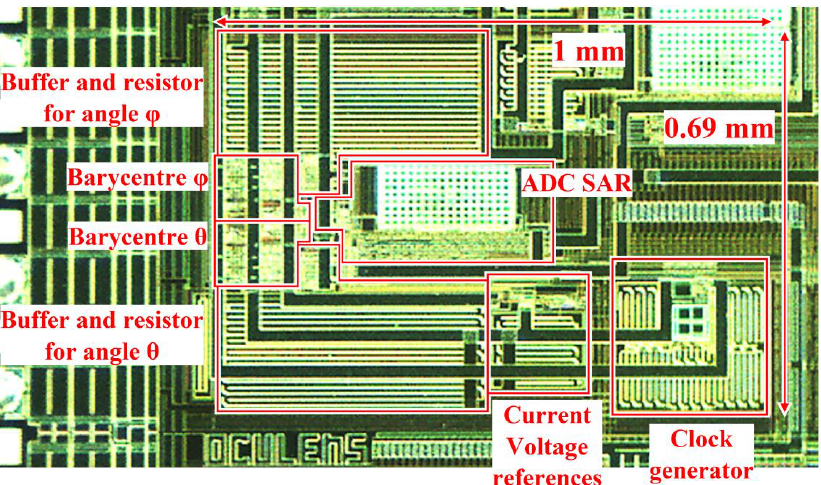
Figure 3. Microphotograph of the fabricated 0.35 µm CMOS ASIC. The circuit supply voltage is 1.8 V and has an active surface area of 0.69 mm 2 .